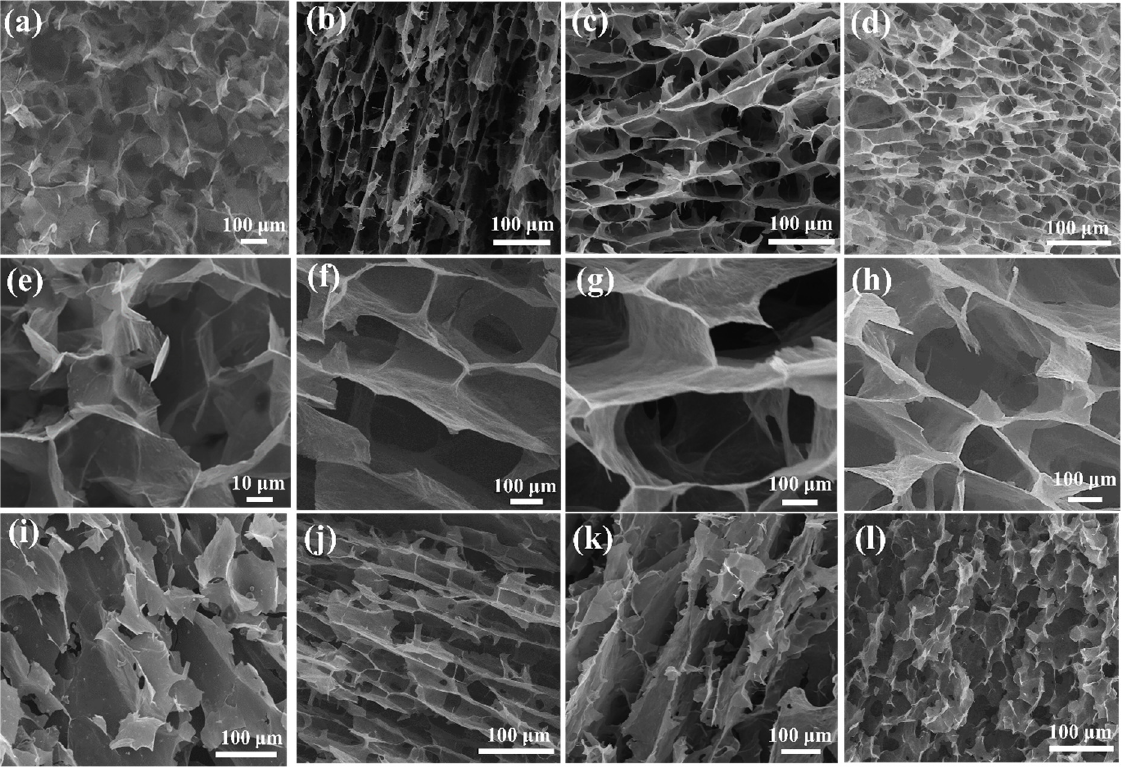
Figure 4. The SEM images of ( a , e , i ) the GOCA, ( b , f , j ) the GCEA-2, ( c , g , k ) the GCEA-1, and ( d , h , l ) GCEA-0.5 (Color figure can be viewed online).